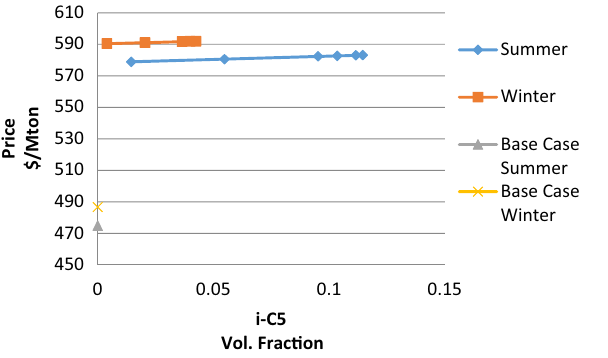
Fig. 32 Effect of adding i-C5 and 20 vol% DME on LPG price